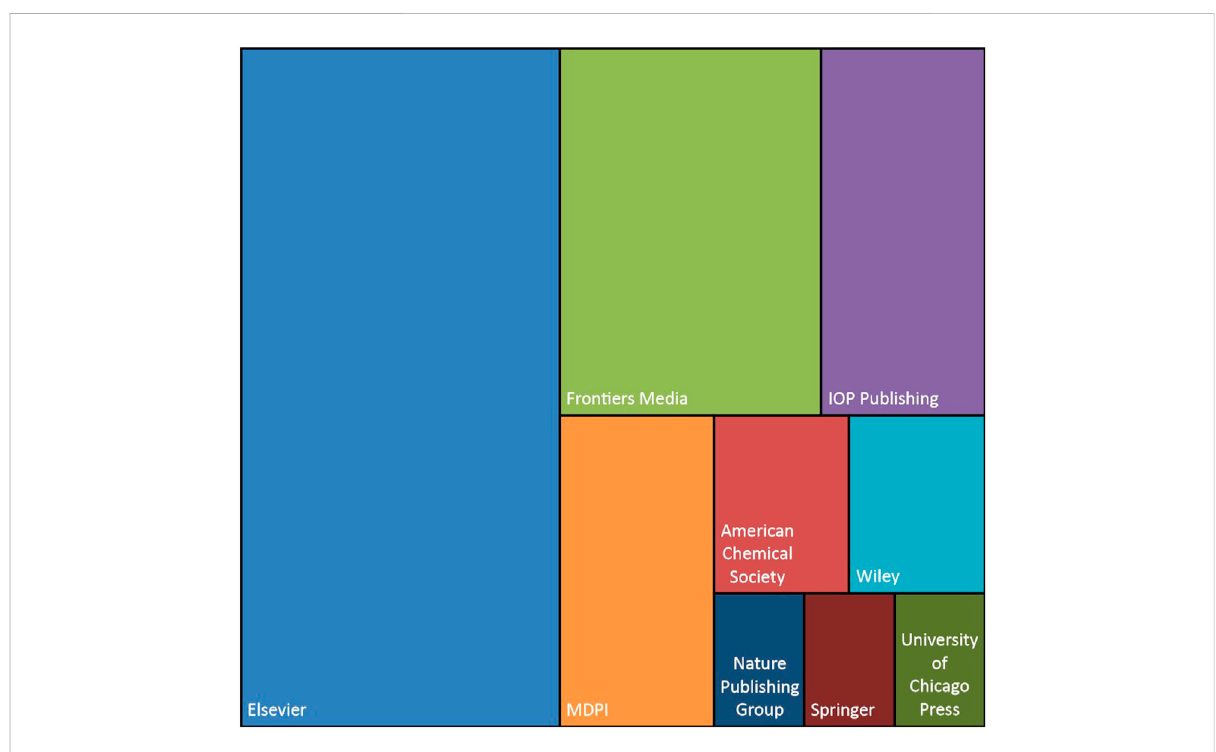
FIGURE 4 Main publishers publishing on macroplastics in rivers.